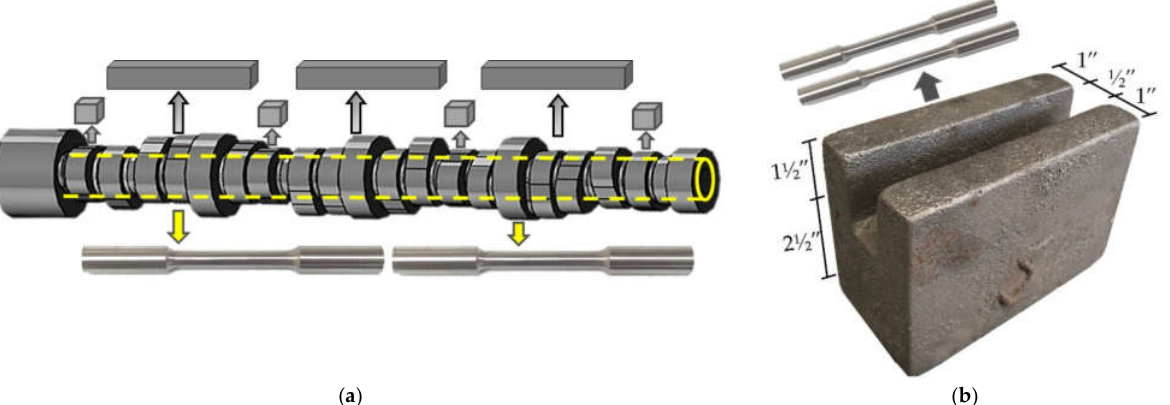
Figure 3. Samples for mechanical properties were obtained from ( a ) Camshafts and ( b ) Keel-block casting.